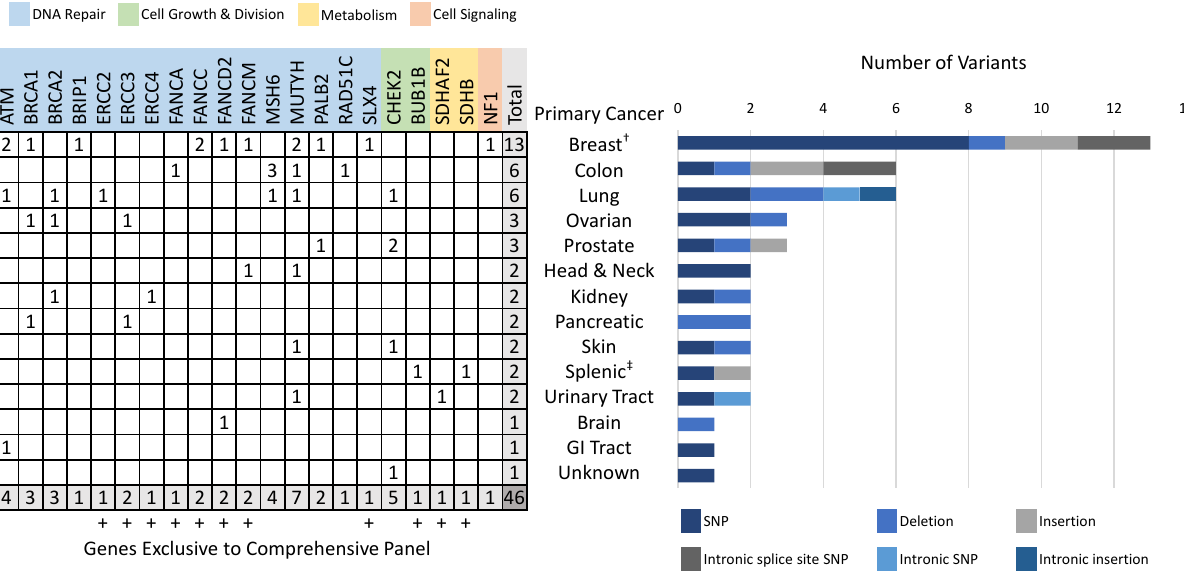
Figure 1. Characterization of gene variants, gene function, genes exclusive to the comprehensive panel, and variant type by primary cancer diagnosis in patients with PGVs. All patients were heterozygous for all variants. Data represents 44 patients, 46 variants. SNP = single nucleotide polymorphism. † , one patient harbored two PGVs (BRIP1 SNP and NF1 insertion). ‡ , one patient harbored two PGVs (SDHB insertion and BUB1B